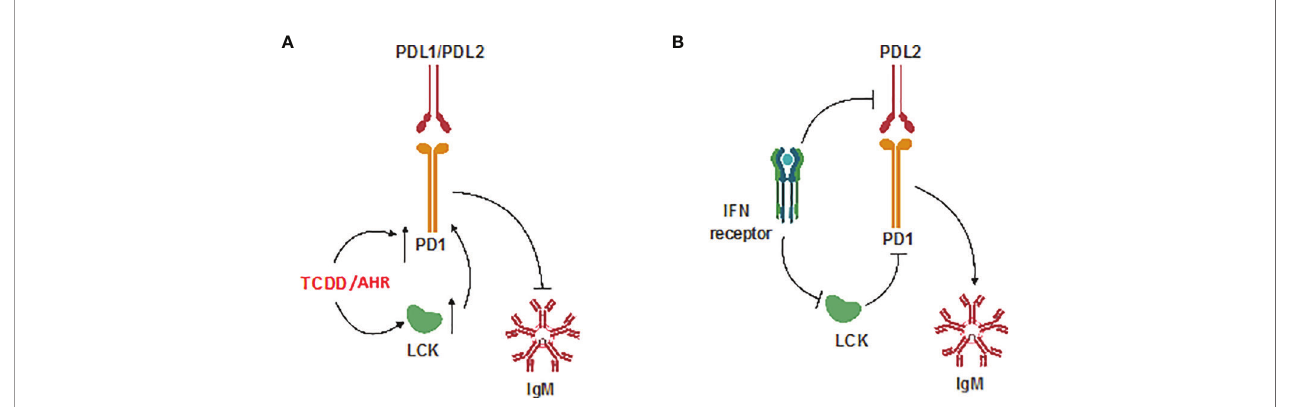
FIGURE 12 | Schematic of potential mechanism. (A) Effect of TCDD-mediated AHR activation; and (B) Effect of IFN g on CD5